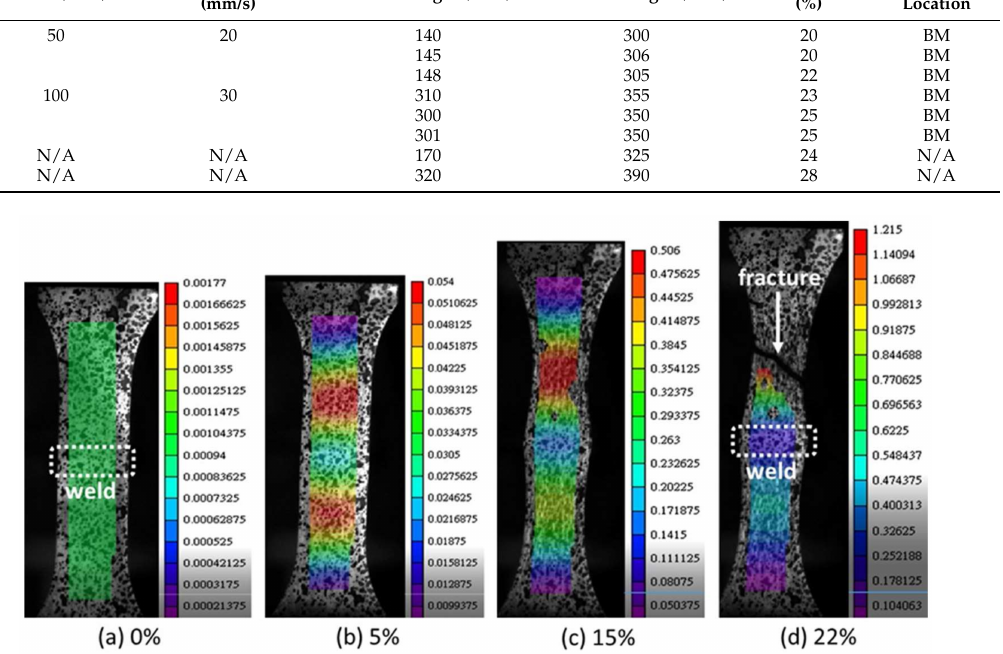
Figure 8. Pictures from digital image correlation (DIC) of CP Ti, 100 µ m, 50 W, and 20 mm/s during tensile testing showing sample conditions at various percentages of strain ( a ) at 0%, ( b ) 5%, ( c ) 15%, and ( d ) 22%, which correspond to fracture. Note: the numbers associated with the images are local strains × 100%.